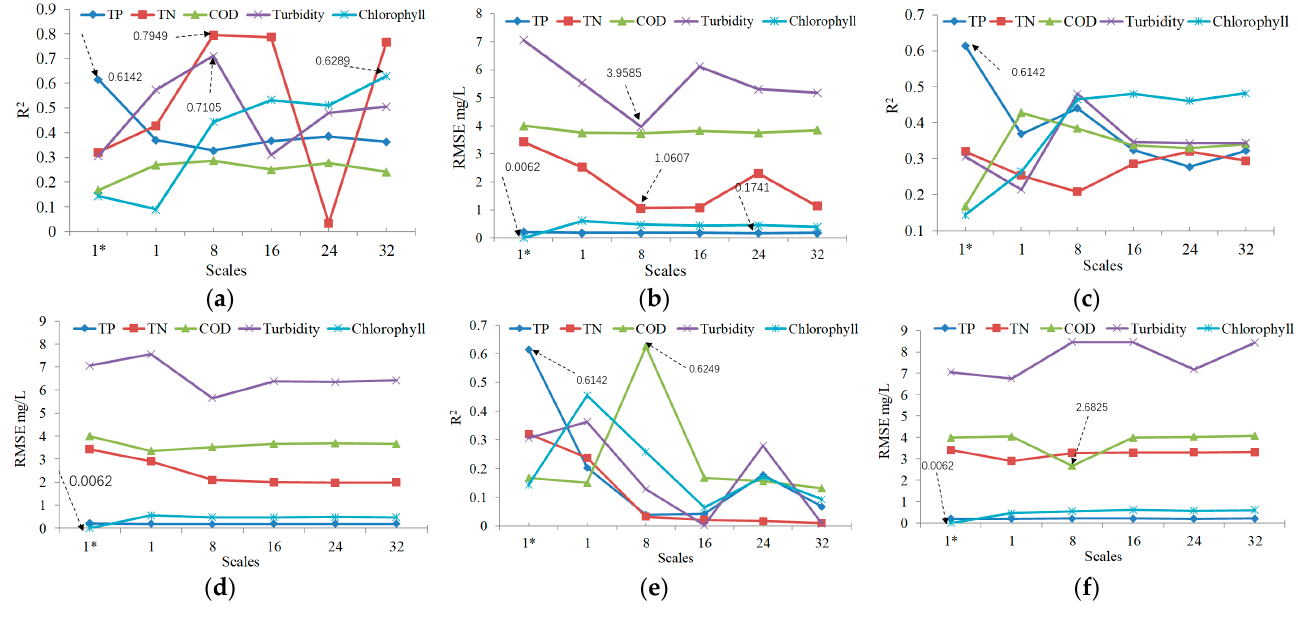
Figure 12. Comparison of regression results between ACR and MLR, SVM, and NN methods. ( a ) R 2 values regressed by ACR method and MLR method at different scales; ( b ) RMSE values regressed by ACR method and MLR method at different scales; ( c ) R 2 values regressed by ACR method and SVM method at different scales; ( d ) RMSE values regressed by ACR method and SVM method at different scales; ( e ) R 2 values regressed by ACR method and NN method at different scales; ( f ) RMSE values regressed by ACR method and NN method at different scales.